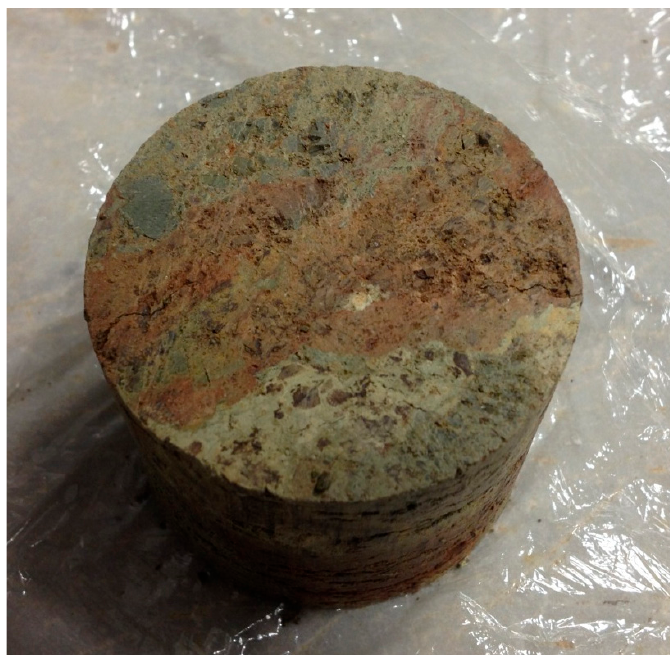
Figure 3. Specimen prepared for suction measurements (50 mm diameter, 40 mm height).